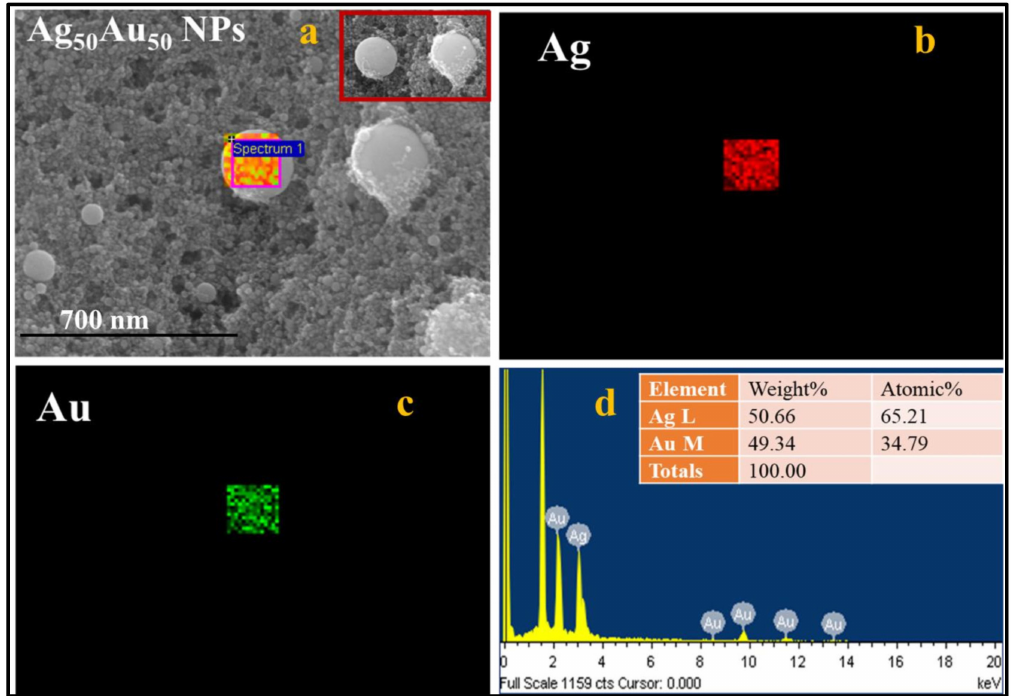
Figure 3. ( a ) FESEM-EDX map image of a Ag 50 Au 50 particle. The highlighted portion was utilized to collect the EDX data while the inset shows the two nanoparticles ( b ) Ag EDX map ( c ) Au EDX map ( b ) EDX spectra of Ag 50 Au 50 NP. The scale bar for ( a – c ) is 700 nm. The inset of ( d ) shows the respective compositions of Ag and Au in a single Ag 50 Au 50